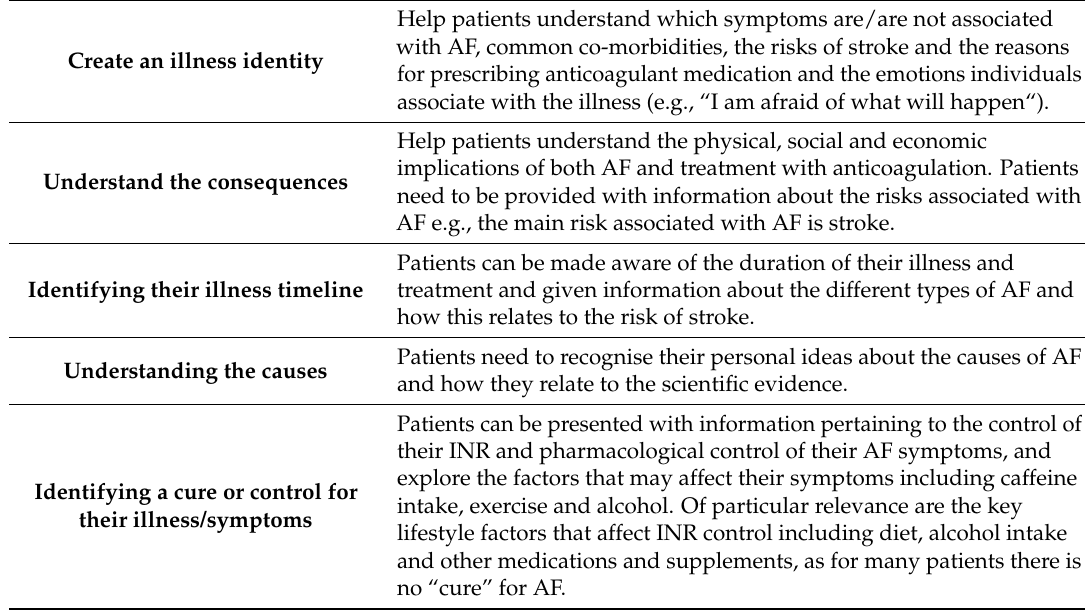
Table 2. Summary of the requirements for patients to create a cognitive representation of